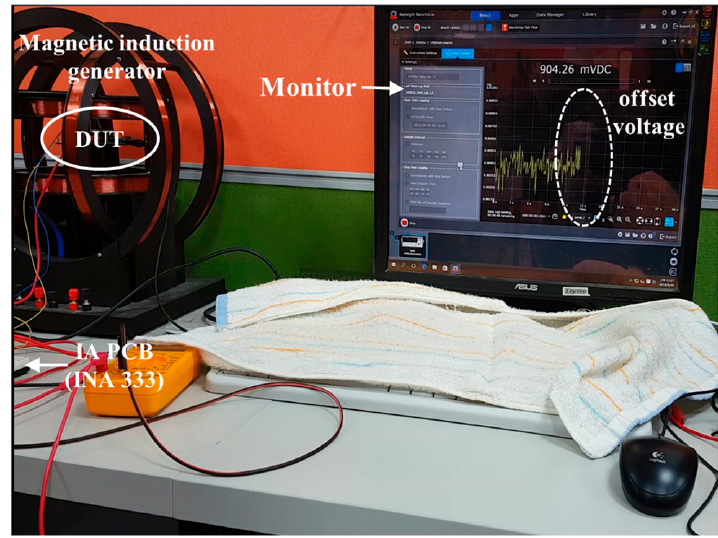
Figure 6. Offset voltage (right circle) displayed on the monitor without a magnetic body and DUT (Device under test) placed in the magnetic induction generator.